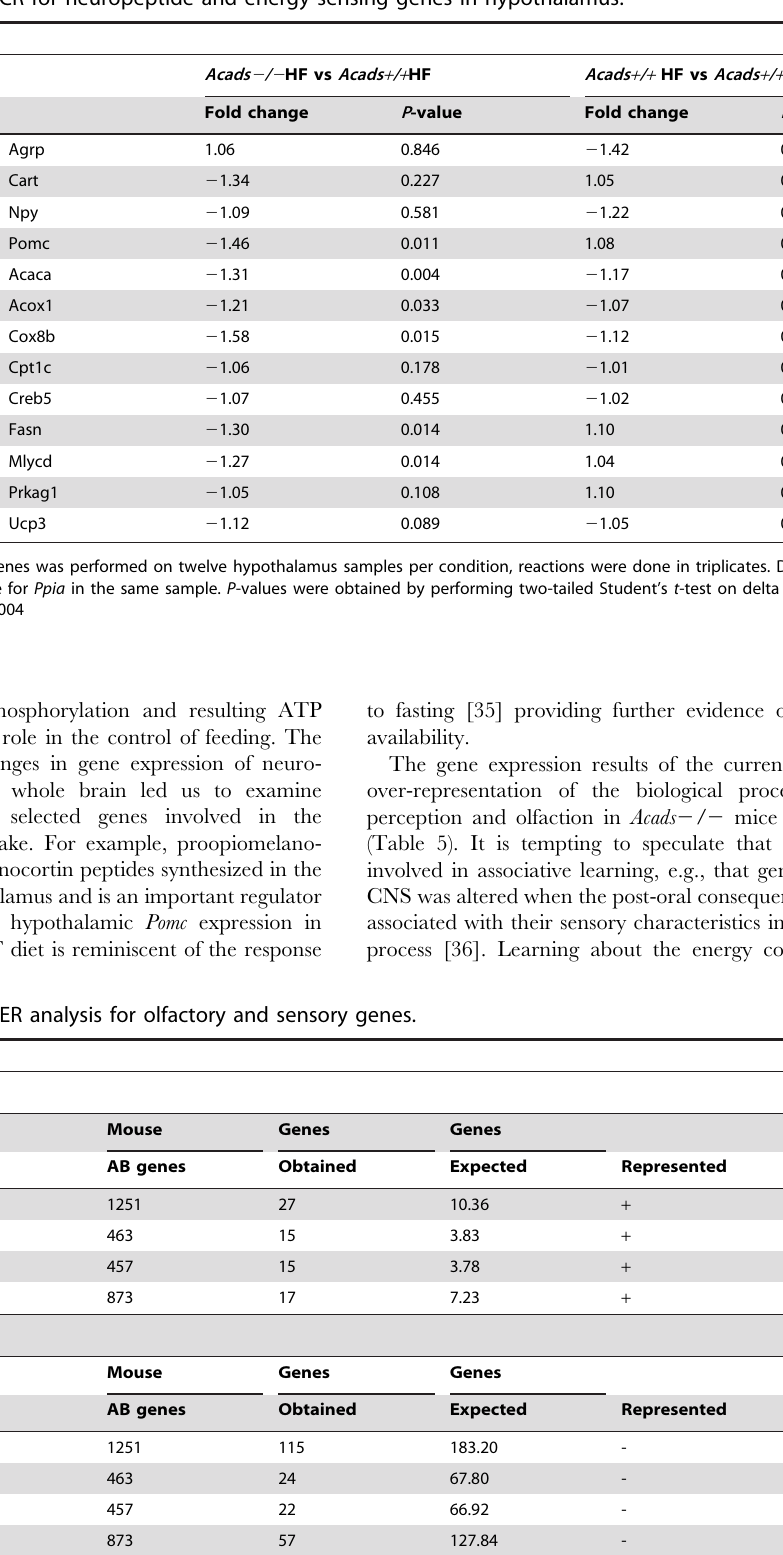
Table 4. Quantitative RT-PCR for neuropeptide and energy sensing genes in hypothalamus.